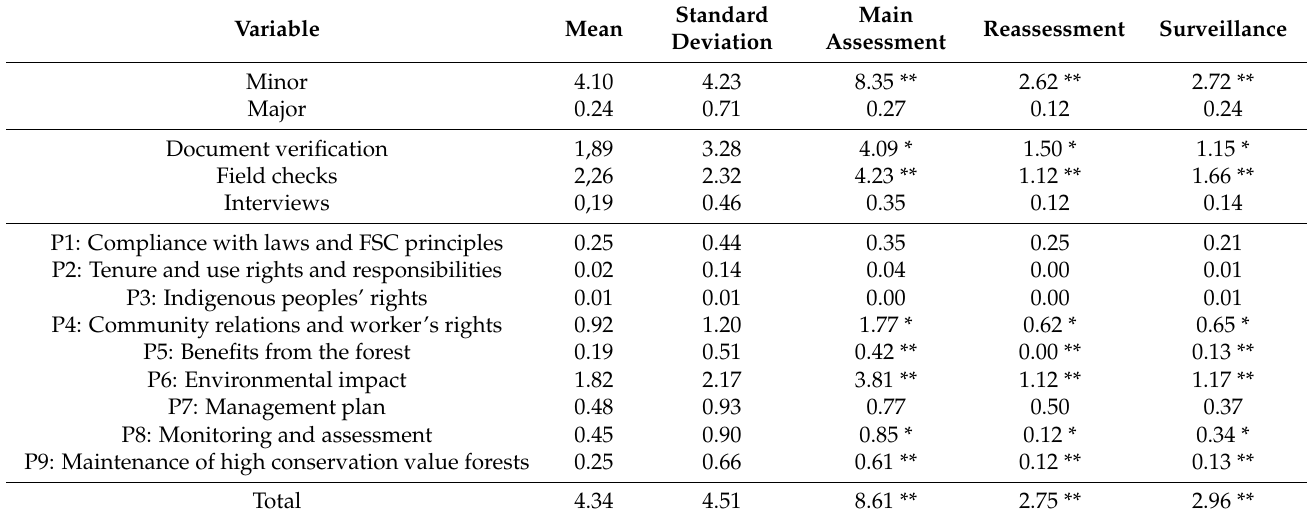
Table 3. Analysis of the NCs detected according to the type of assessment.